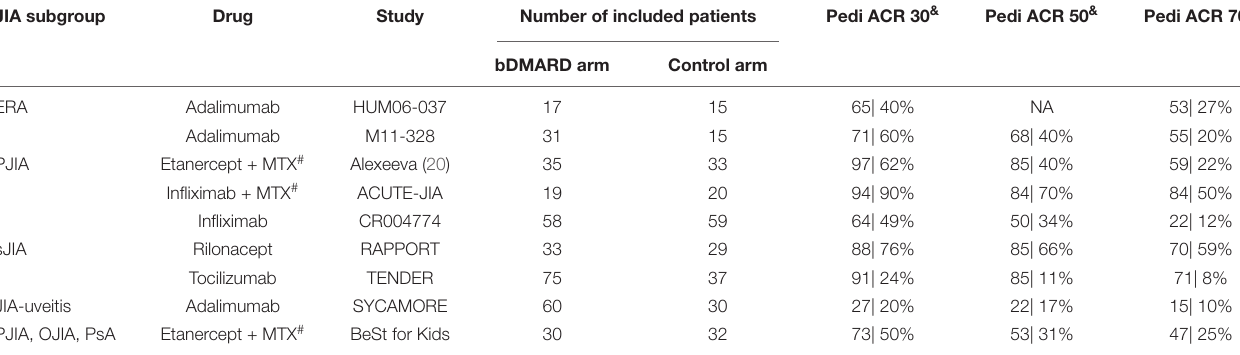
TABLE 2 | Overview of Pedi ACR 30/50/70 data at 3 months (e.g., weeks 12–14) in JIA RCTs. JIA